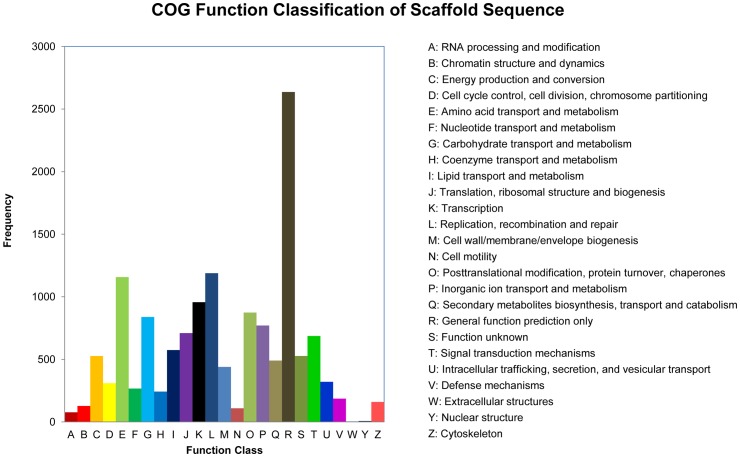
COG functional classification of the beet armyworm transcriptome.Orthologous analysis of 18,592 Trinity contigs was performed using the Blastall software against Cluster of Orthologous Groups (COG) database. The clusters “general function prediction only” and “Replication, recombination and repair” were abundant in the beet armyworm transcriptome data.